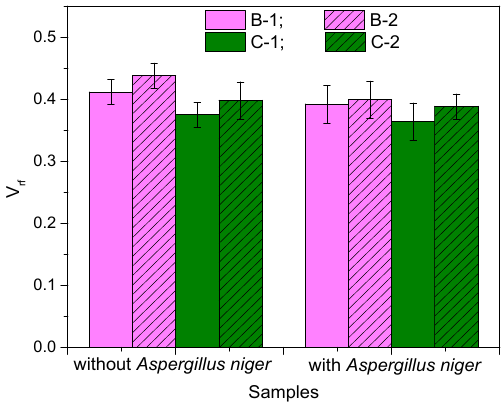
Figure 6. V rf (volume fractions of rubber in the fiber-filled swollen composite) of the composites before and after incubation with Aspergillus niger .